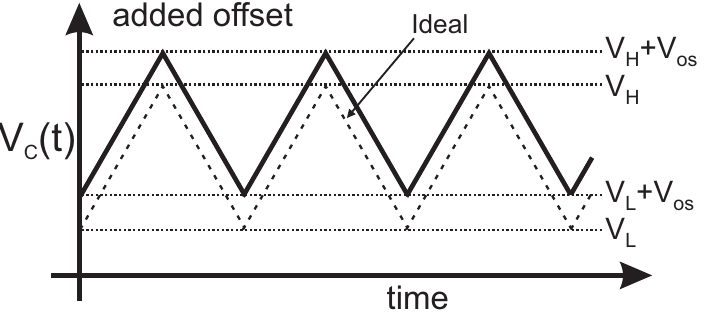
Figure 7. Effect of the comparator offset in the input